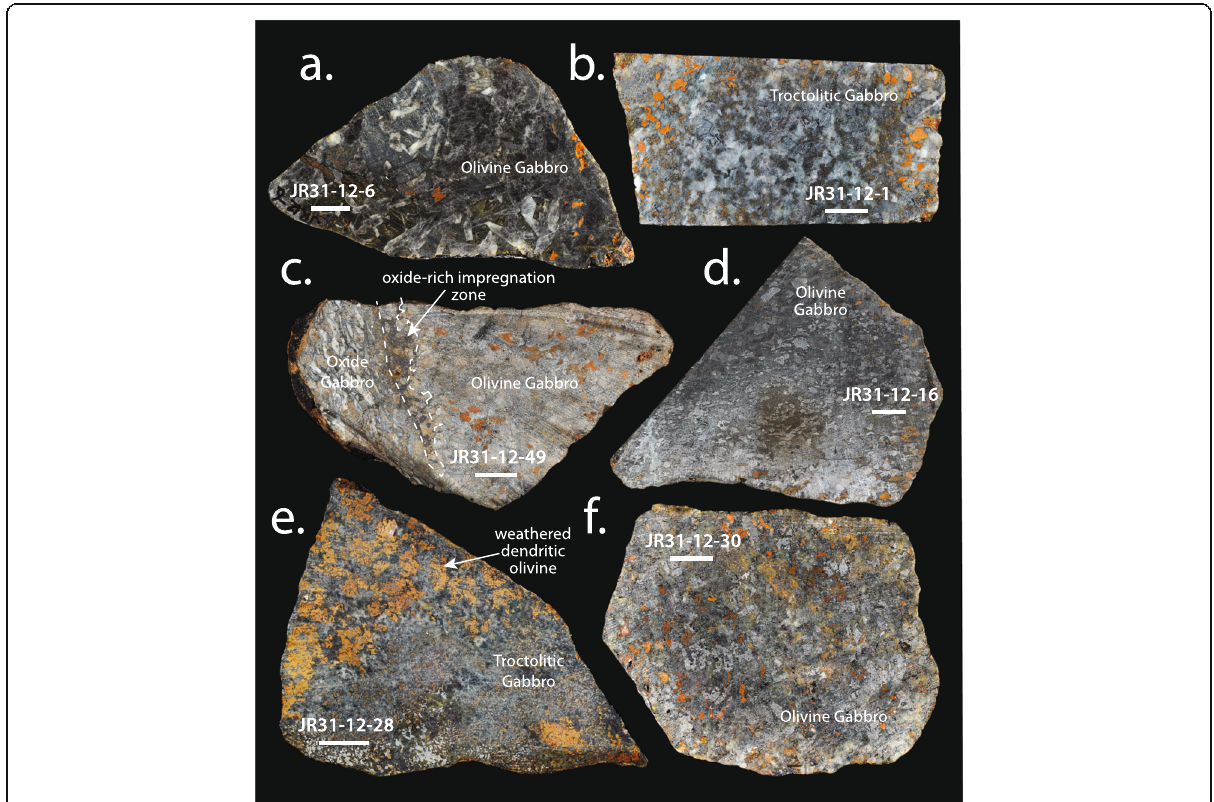
Fig. 23 Examples of Atlantis Bank seafloor olivine gabbros selected from Dredge JCR31-12 from a landslip headwall at the northern end of the gabbro massif (Fig. 3). a Undeformed intergranular olivine gabbro with large centimeter-scale plagioclase laths. b Olivine troctolitic-equigranular gabbro with orange clay replacing olivine on margins. c Equigranular olivine gabbro crosscut by a high-temperature (e.g., 600 – 1000 °C) protomylonite oxide gabbro imaged dry to enhance Fe-Ti oxides impregnating and replacing the silicate matrix of the undeformed olivine gabbro adjacent to the contact. d Equigranular olivine gabbro with a possible weakly deformed magmatic foliation grading from coarse- to medium-grained gabbro perpendicular to the foliation. e Unusually olivine-rich, troctolitic gabbro with dendritic-structured olivine intergrown with equigranular sub-millimeter-scale augite and plagioclase chadocrysts. f Olivine gabbro with characteristic sub-ophitic augite and intergranular